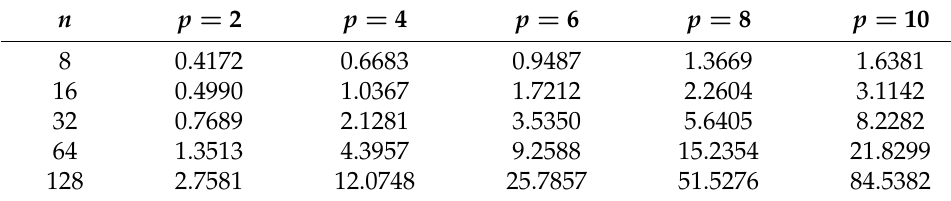
Table A3. Execution time (ms) of PDIST . EncodeY operation on desktop PC.